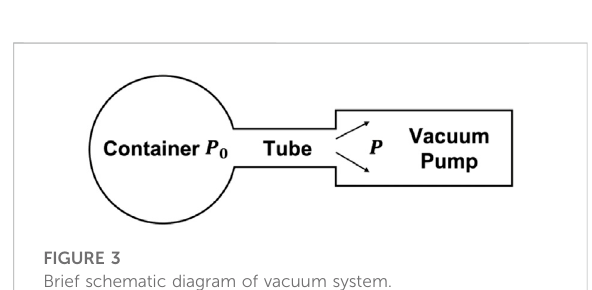
FIGURE 3 Brief schematic diagram of vacuum